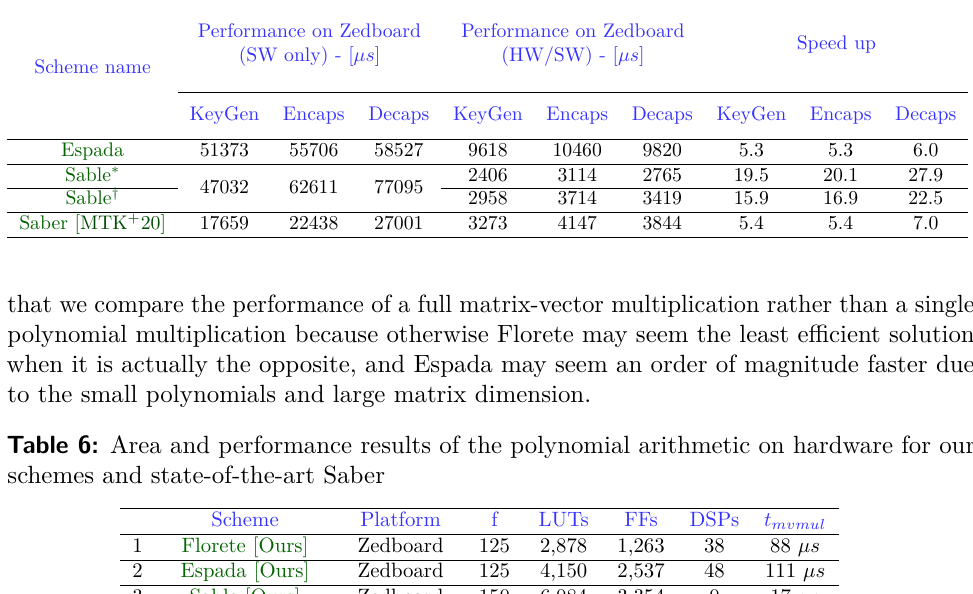
Table 5: Performance comparison between schoolbook implementations on software and the speed-up achieved by the polynomial multiplier on hardware. ∗ using the high speed 256 × 256 multiplier † using the compact 256 × 256 multiplier